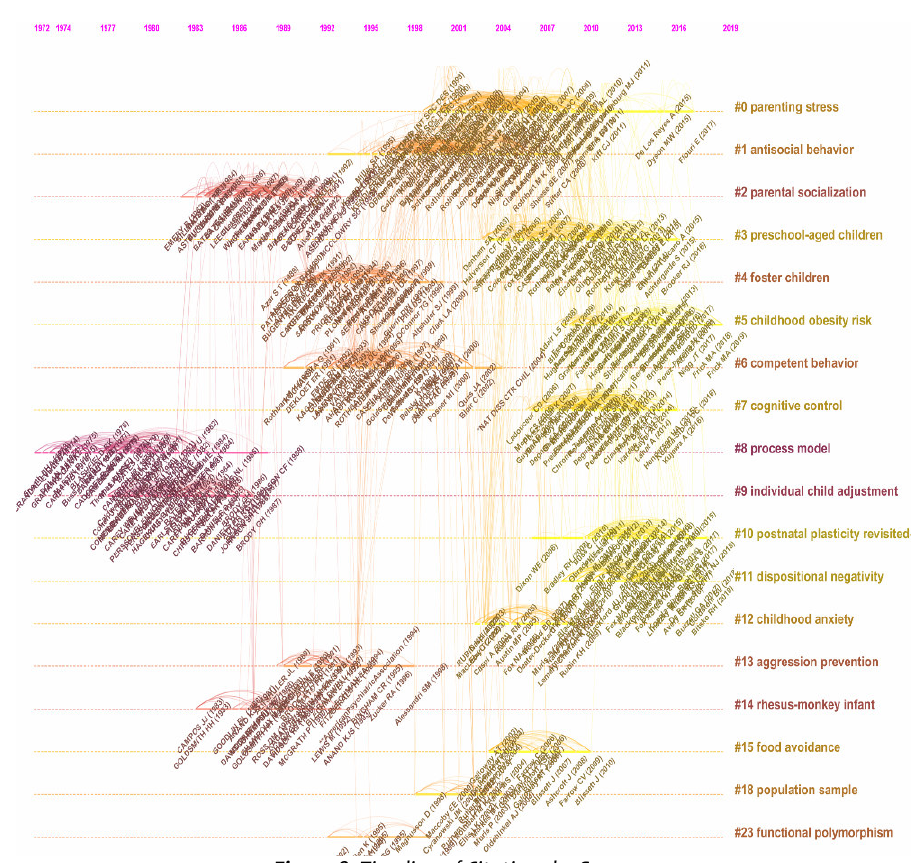
Figure 8. Timeline of Citations by